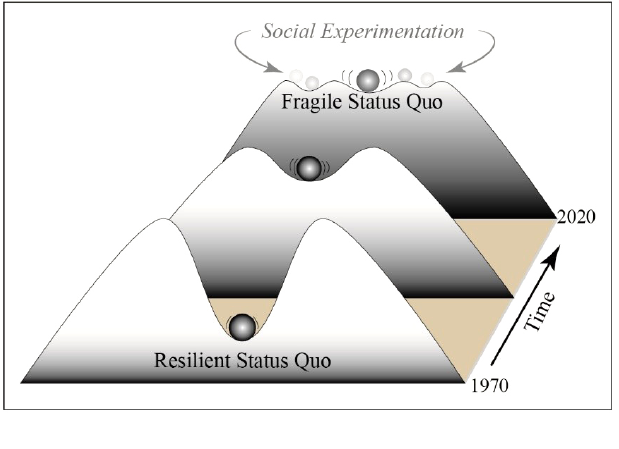
Fig. 1 . Schematic representation of the hypothesized change over the past half century from a dominant social attractor to a situation where the attractiveness of this status quo has declined and social exploration of alternative options becomes more common. The horizontal axis represents a one- dimensional projection of the way society is organized. Slopes in these stability landscapes correspond to rates of change (Scheffer et al. 2012). The deeper the valley, the more energy is required to escape the basin of attraction. The landscape at the back is a cartoon of how we interpret the current situation: as the basin of attraction of the status quo has shrunken, temporal shifts of social groups or entire nations to alternative configurations become easier and more